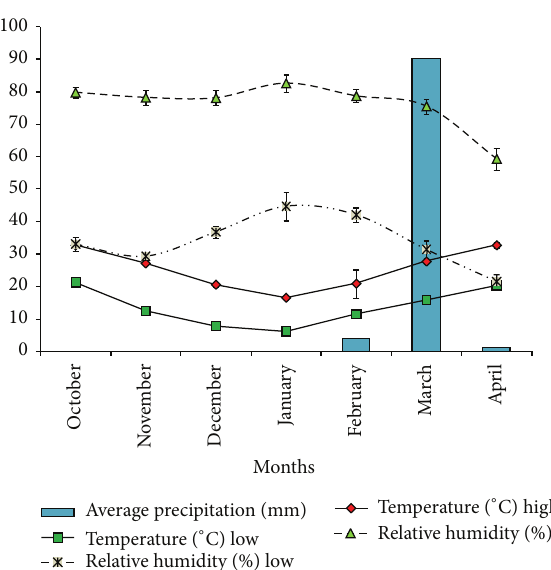
Figure 1: Meteorological data showing variations in temperature, relative humidity, and precipitation levels during thegrowing season of calendula. Sampling was done in the last week of February.